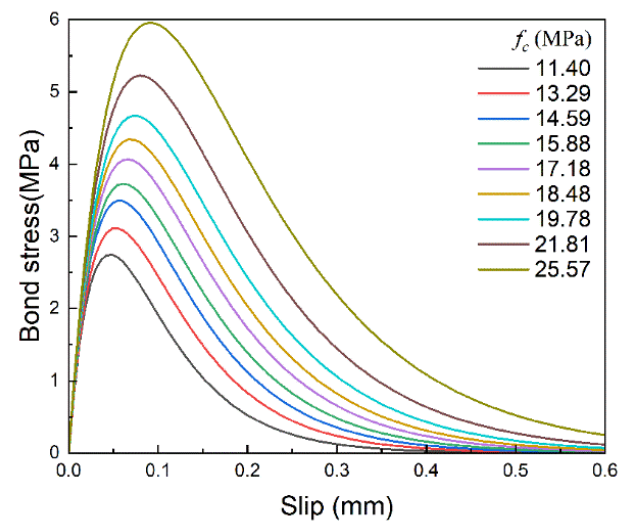
Figure 20. Bond–slip curves with different brick strength.